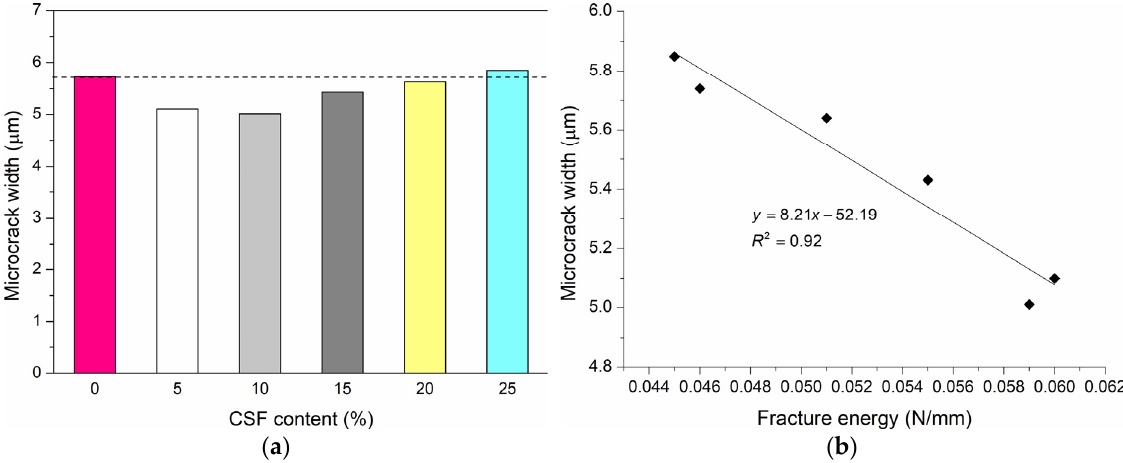
Figure 15. ( a ) Variation of microcrack width with SF content; ( b ) correlation between microcrack width and fracture energy after 28 days.